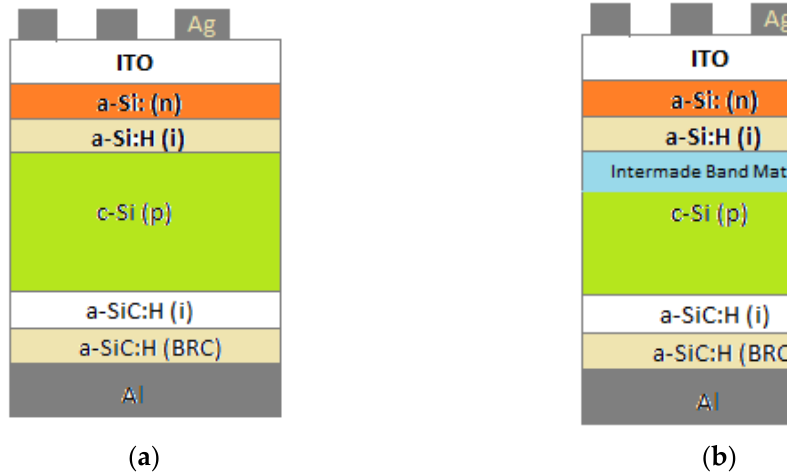
Figure 4. An example of structure of the reference HIT solar cell ( a ) and IBSC ( b ) used in [64]. In this study, the researchers created various IBSCs based on a hyperdoped silicon semiconductor with Ti and V. These cells have an efficiency of 2.6% and 1.9%, respectively, and exhibit a silicon subbandgap EQE. Analysis of J–V measurements showed three main conduction processes and series resistance. The main exponential mechanism observed in all temperature ranges in this study has an ideality coefficient of 1 < n1 < 2 and an activation energy of Ea (Ti) = 0.55 eV and Ea (V) = 0.56